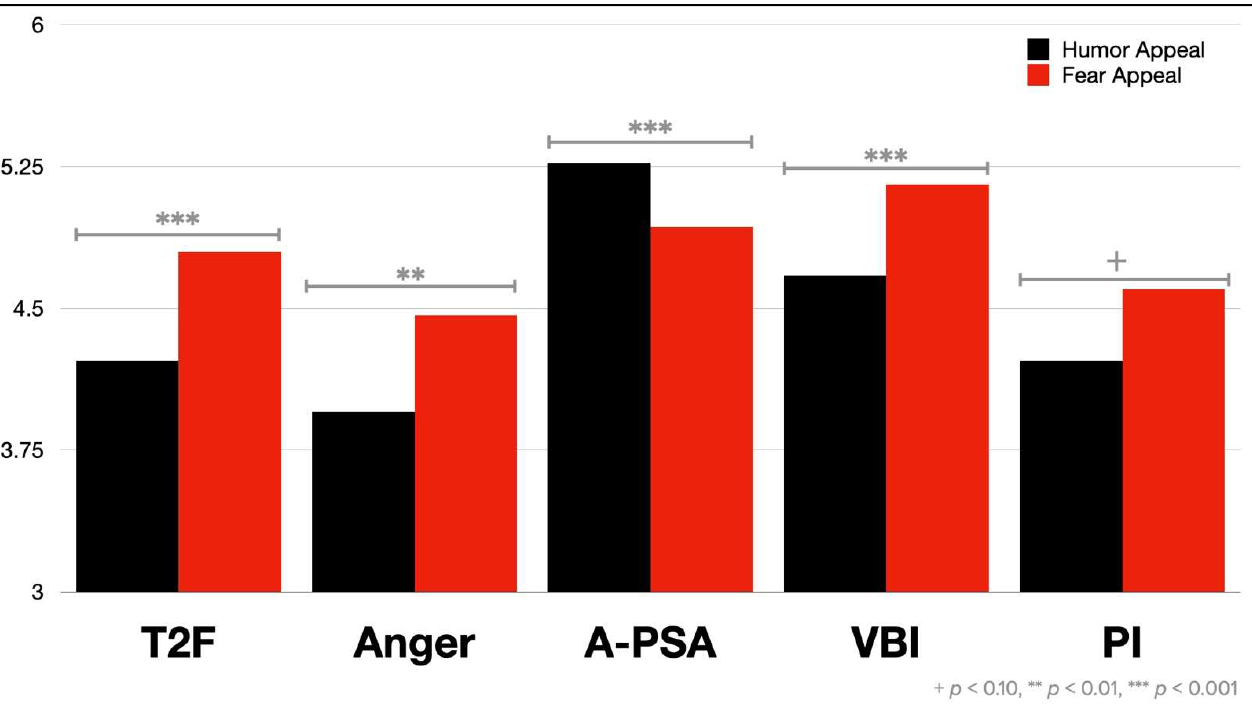
Figure 2. Means of major dependent variables, by persuasive appeal.